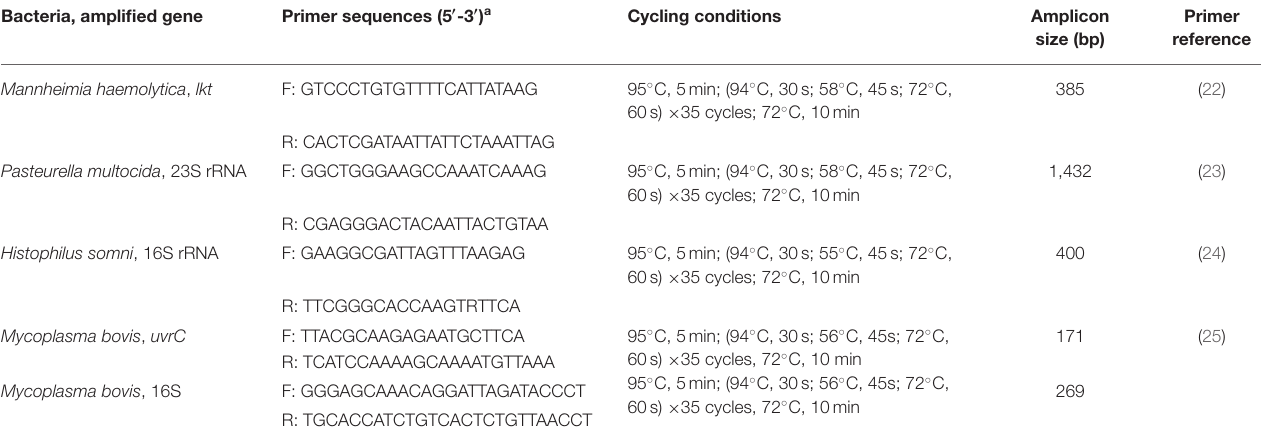
TABLE 1 | Oligonucleotide primers, PCR protocols, and amplicon sizes for each cPCR